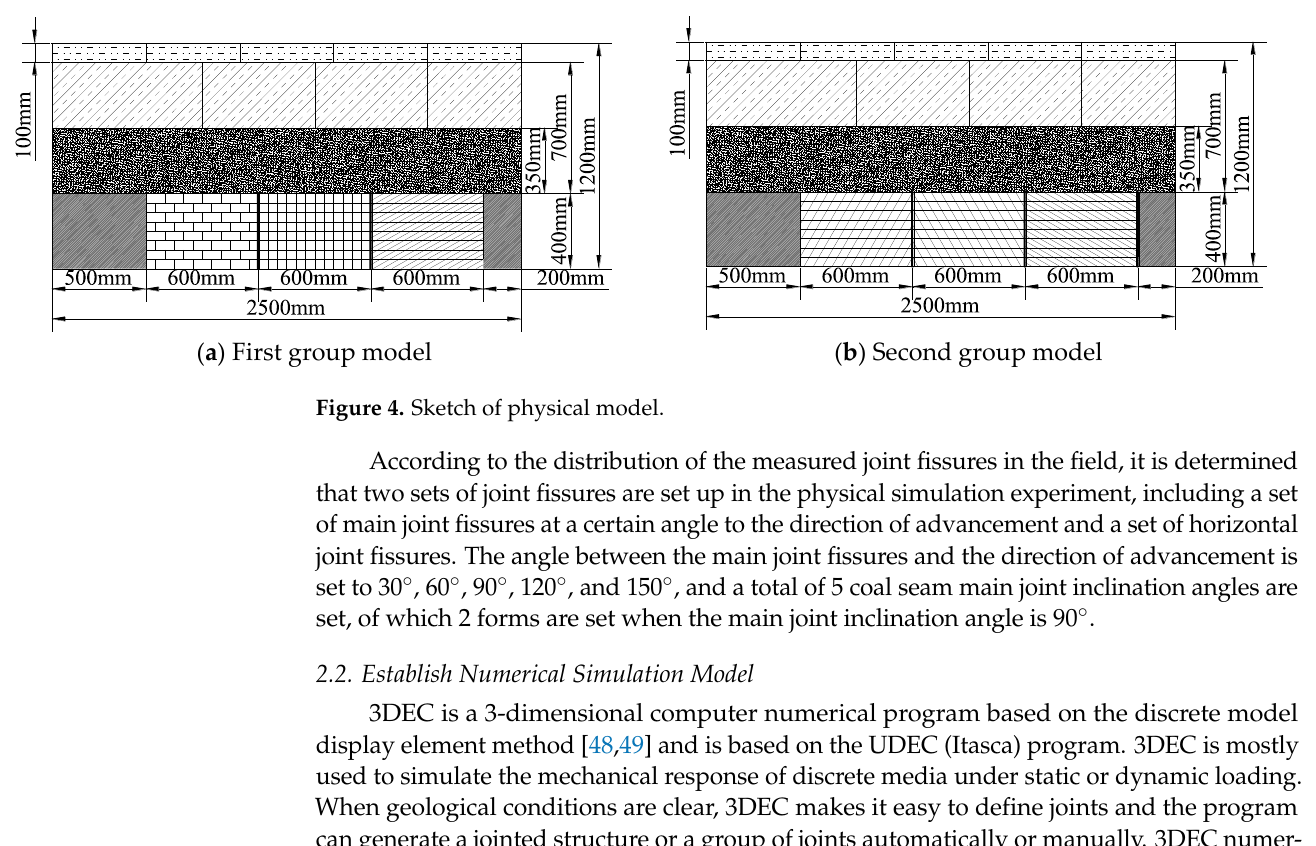
Figure 5. 3DEC numerical simulation model.